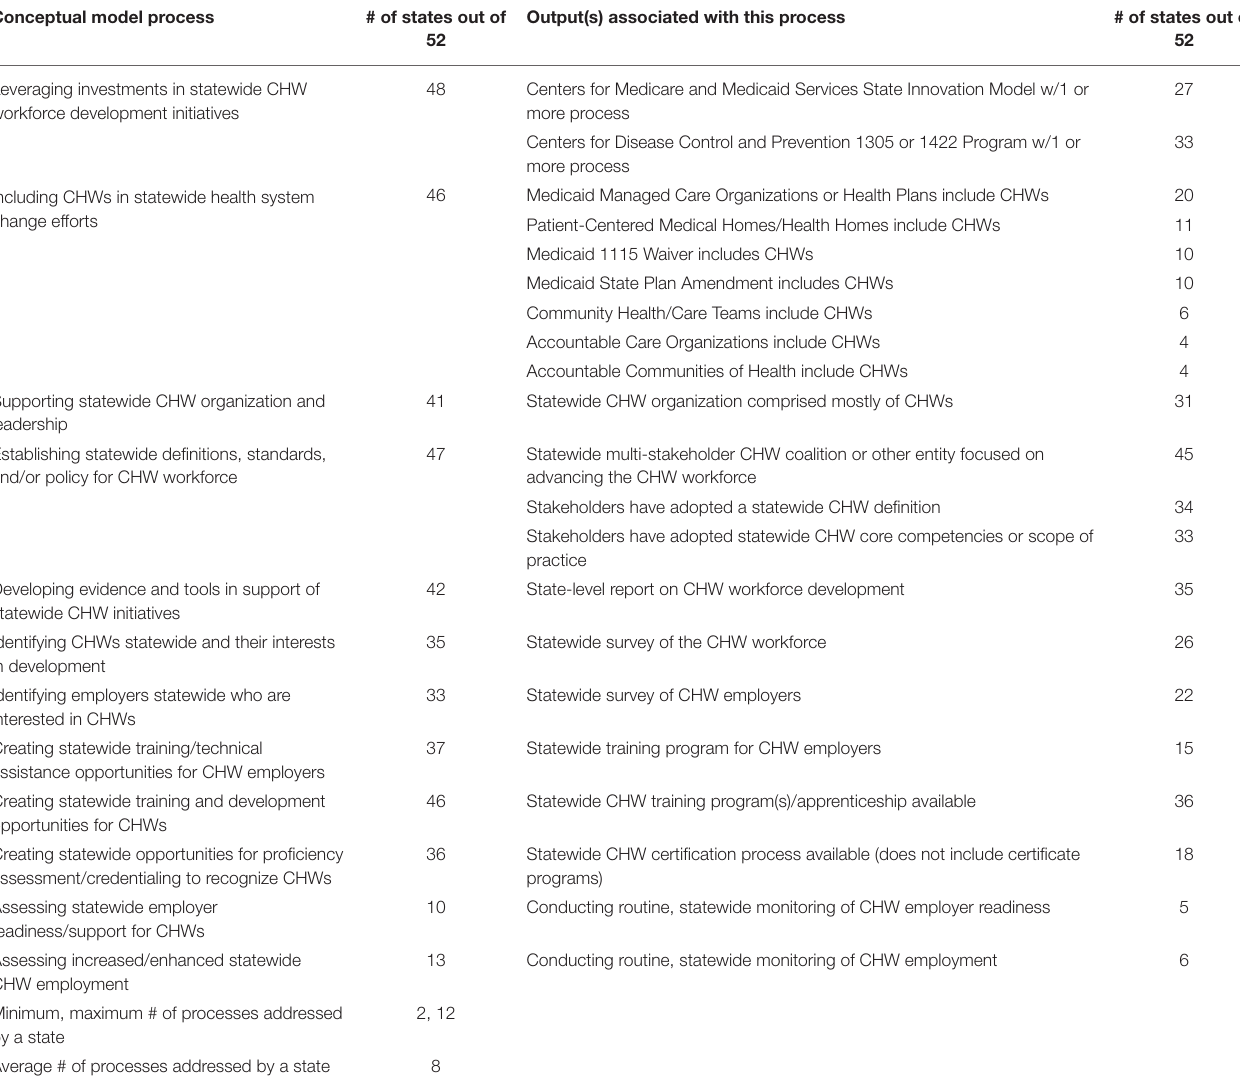
TABLE 1 | Community health worker (CHW) workforce development initiative processes and outputs for the 50 states, D.C. and Puerto Rico as of September 2020 a . Conceptual model